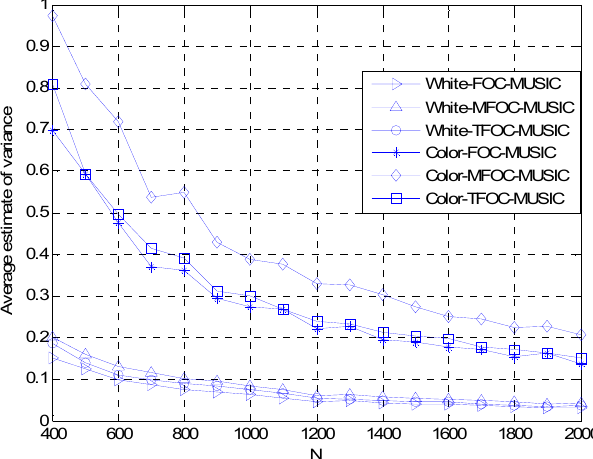
Figure 7. Average estimate variance comparisons versus snapshots L